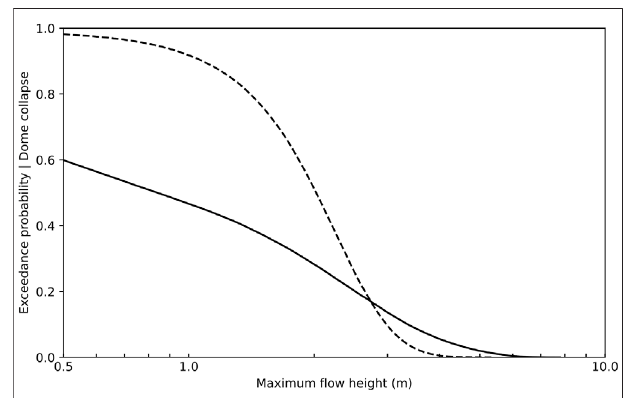
FIGURE 6 | Estimated exceedance probability (conditional on an eruption and dome collapse) for block-and-ash fl ow heights from the current summit dome location and orientation (dashed line) and from a new summit dome location and orientation (solid line, also conditional on a dome growth episode).